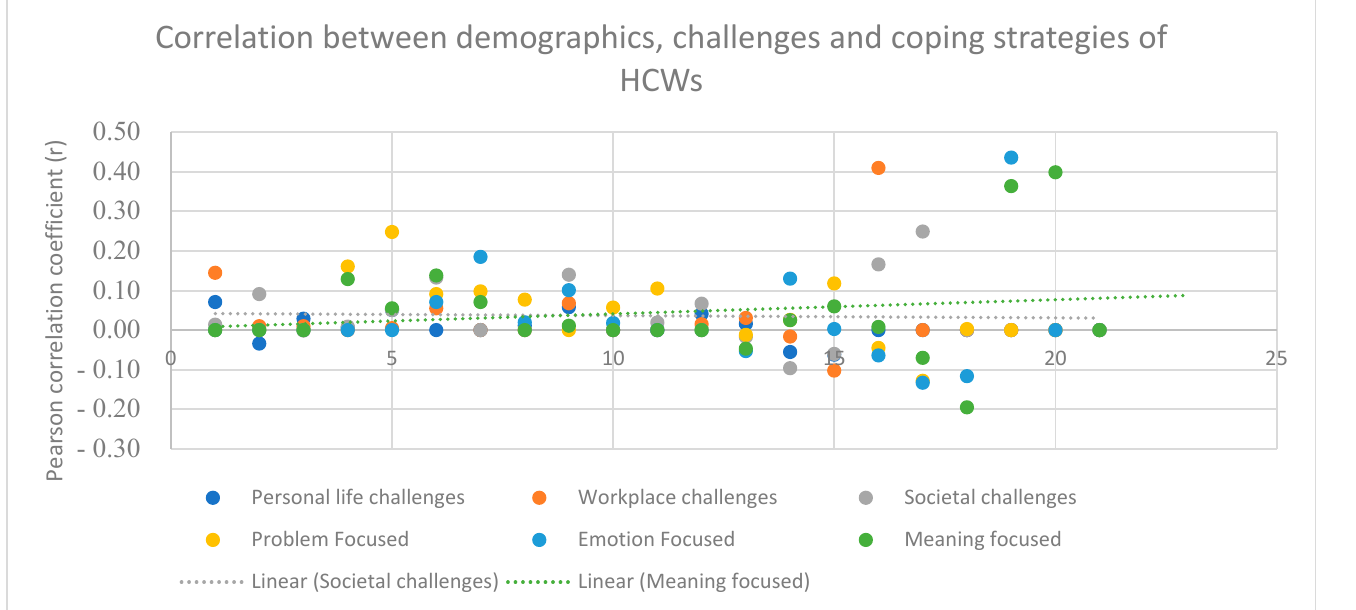
Figure 2. Scatter graph of correlation between demographic variables, challenges and coping strat- egies of HCWs.